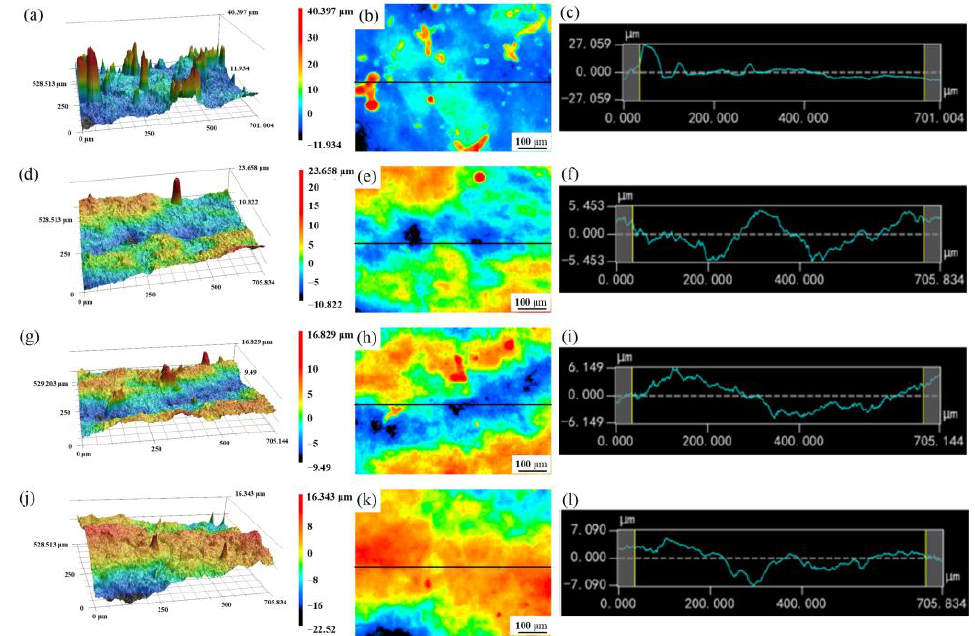
Figure 13. Three-dimensional profile of Al cross-section: ( a – c ) front waist; ( d – f ) peak; ( g – i ) back waist; ( j – l ) trough.